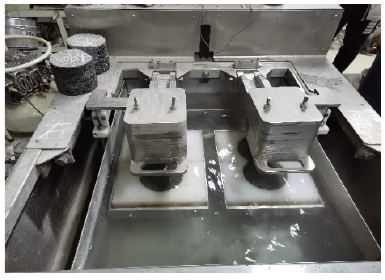
Figure 12. HWTT apparatus.